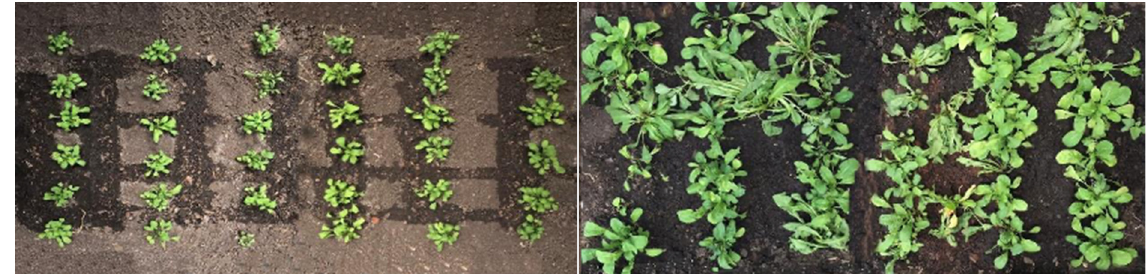
Figure 11. Images of the crop at different stages of development, used in the evaluation of processing methods.